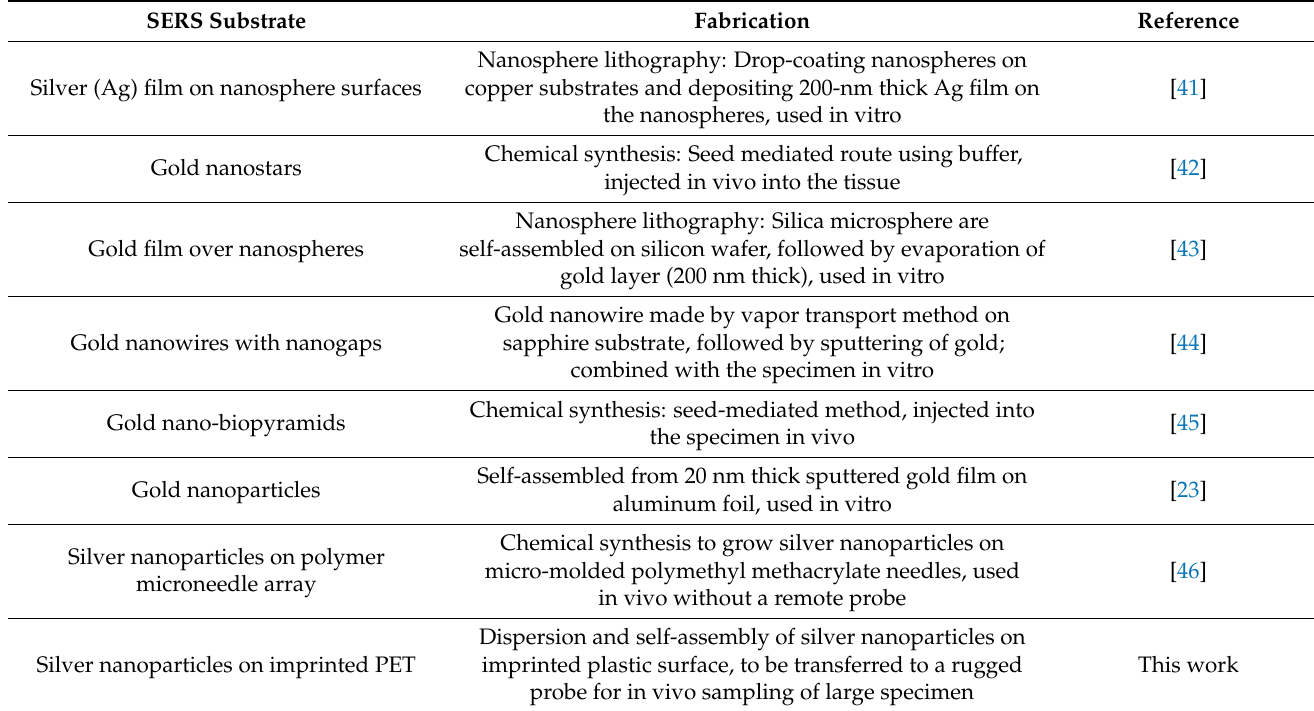
Table 1. Summary of different SERS substrates reported for bio-probe